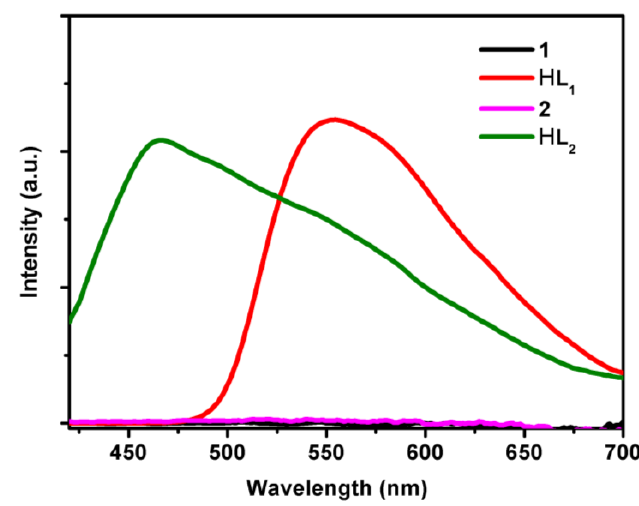
Figure 12. Emission spectra of H L 1 , H L 2 , 1 , and 2 in solid state.